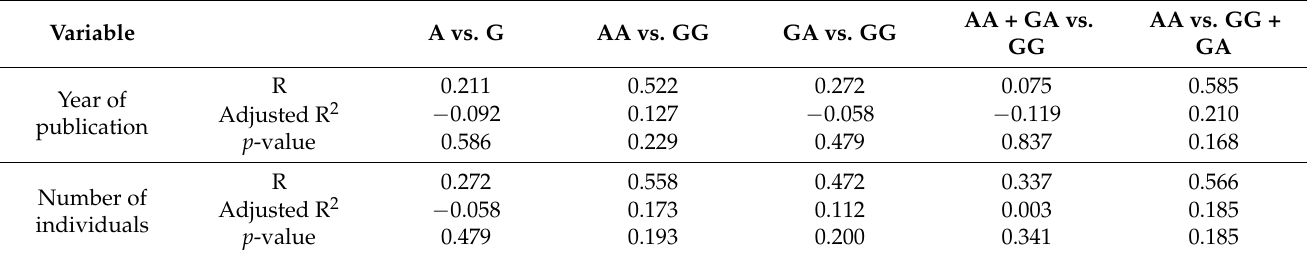
Table 9. Meta-regression for TNF- α ( − 308 G > A) polymorphism based on publication year and sample